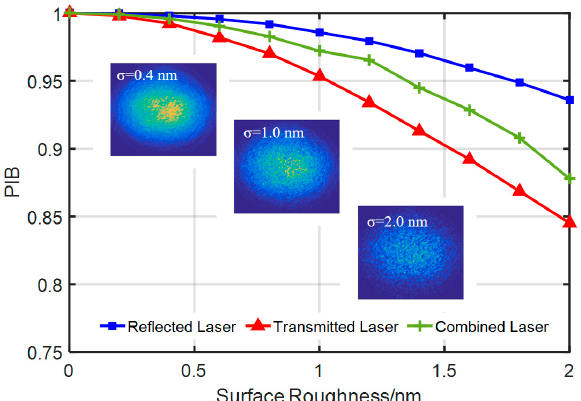
Figure 11. The measured complex amplitudes of the incident lasers.